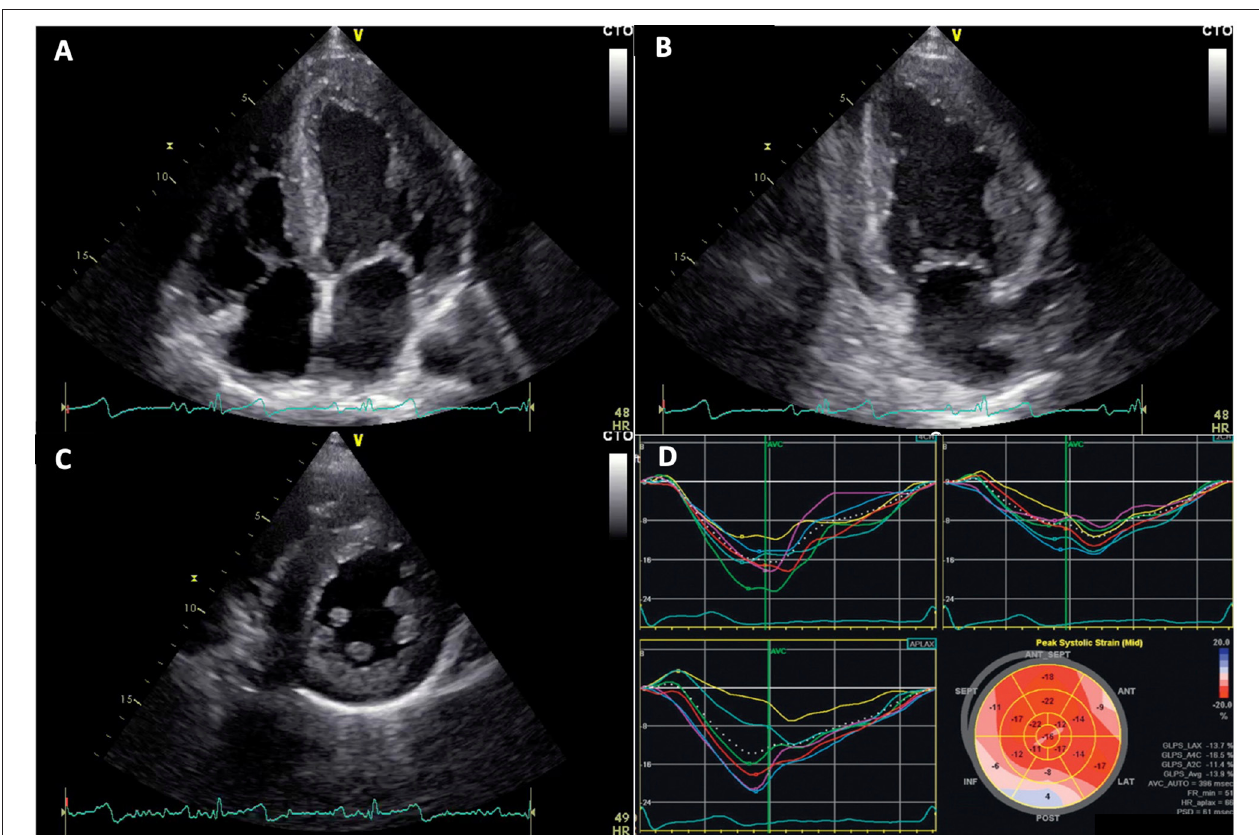
FIGURE 2 | Echocardiographic images of Fabry disease (FD) patients. (A–C) apical 4 chambers, 2 chambers, and parasternal short axis views showing left ventricular concentric hypertrophy typical of FD, respectively. (D) altered global longitudinal strain in patient with FD, note inferolateral segment